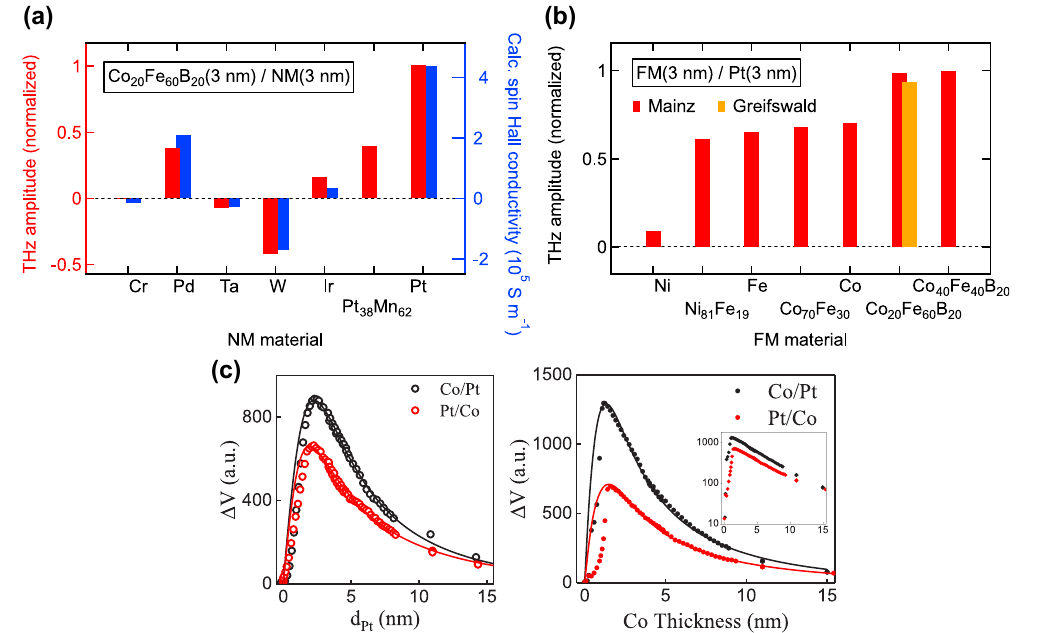
Figure 13: (a)NMmaterialvariation.DependenceoftheterahertzemissionamplitudefromCo 20 Fe 60 B 20 | NMbilayersontheNMmaterial(redbars), alongwiththecalculatedvaluesofthespin-Hallconductivity(bluebars).(b)FMmaterialvariation.Dependenceoftheterahertzemissionamplitude from spintronic bilayers on the FM material. Reprinted (adapted) by permission from [56]. Copyright (2016) by Springer Nature. (c) Thickness dependence. Terahertz-emission amplitude for varying NM (left) and FM (right) thicknesses for FM/NM and reversely grown bilayers. Reprinted (adapted) by permission from [136]. Copyright (2018) by American Physical